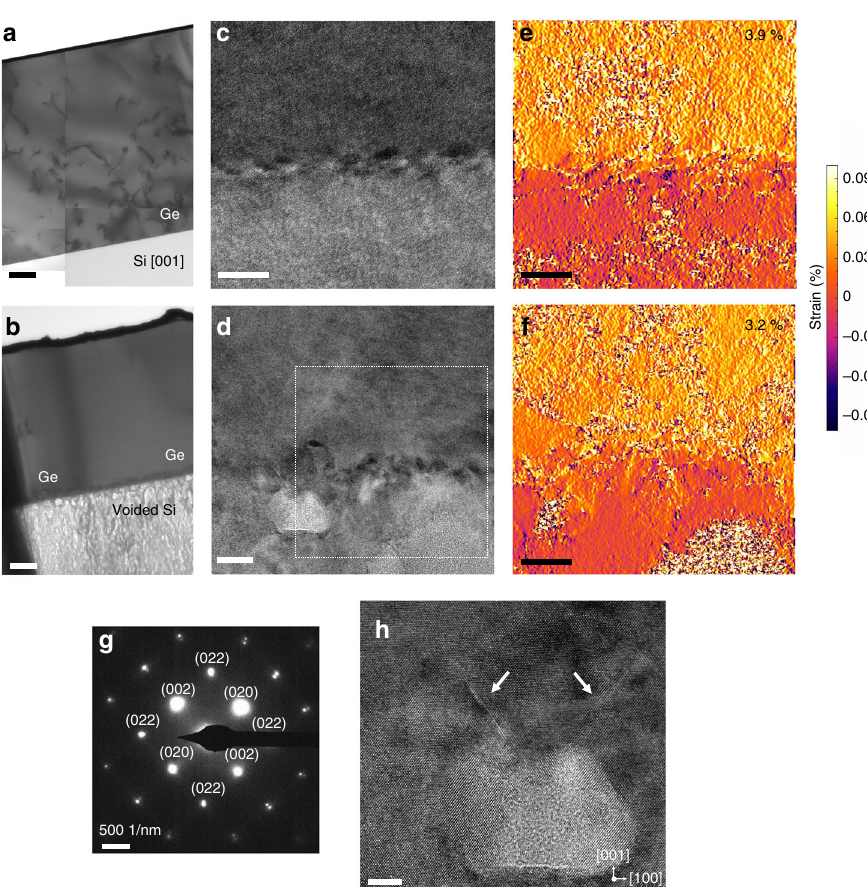
Fig. 5 Dislocation/void interaction in the Ge/Si interface. a Low magni fi cation bright fi eld transmission electron microscopy (BF-TEM) images of the Ge/Si reference substrate and b the NVS with very few defects within the Ge layer. Scale bars 200 nm. High-resolution TEM images from the Ge/Si reference ( c ) and the NVS ( d ) show a dense dislocation network close to the Ge/Si interface. Scale bars of c and d are 10 and 20 nm, respectively. e , f Experimental strain components ε xx at the Ge/Si heterostructure interface for both substrates exhibit a better strain relaxation of the Ge layer in the case of the NVS. Scale bars 10 nm. g Selected area electron diffraction (SAED) patterns from the NVS show a monocrystalline quality of the Ge layer. h Atomic-resolution TEM image shows the annihilation of dislocation segments coming from the Ge/Si interface at the void located in the Si substrate. The arrows in h shows two dislocations bend towards the voided area, instead of emerging at the Ge surface. Scale bar 5